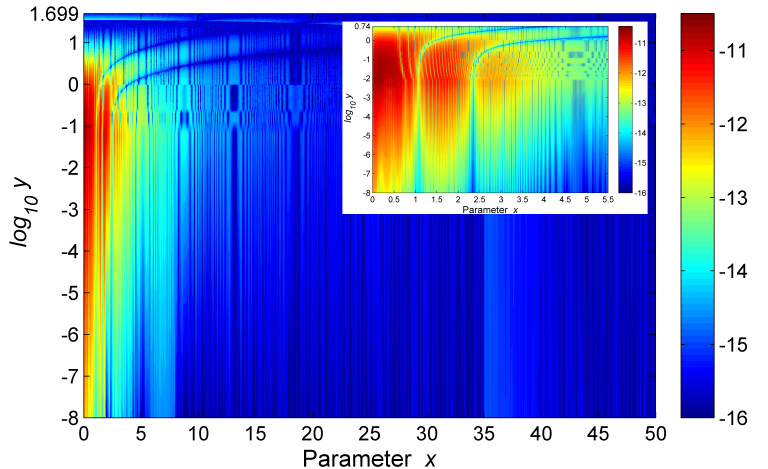
Figure 4. Relative error ∆ Im for the imaginary part L ( x , y ) of the complex error function. Inset shows the relative error ∆ Im in the area near the